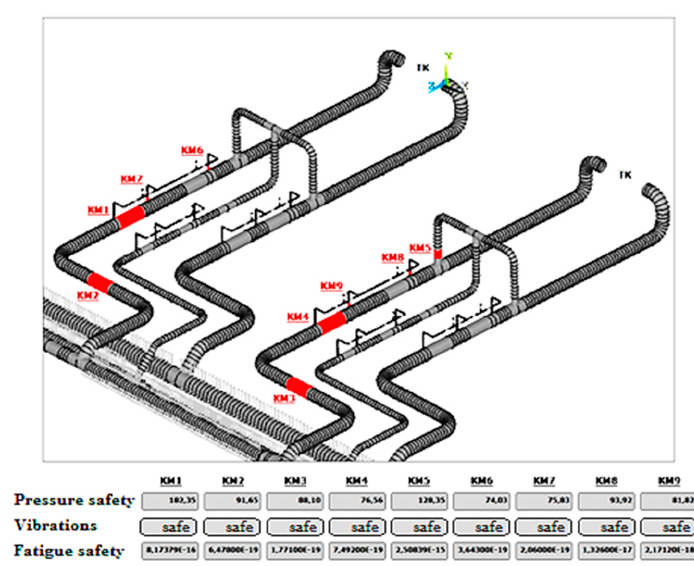
Figure 6. Main screen of the monitoring system for the super-structure of the pipeline yard above the ground installed at the compressor station.